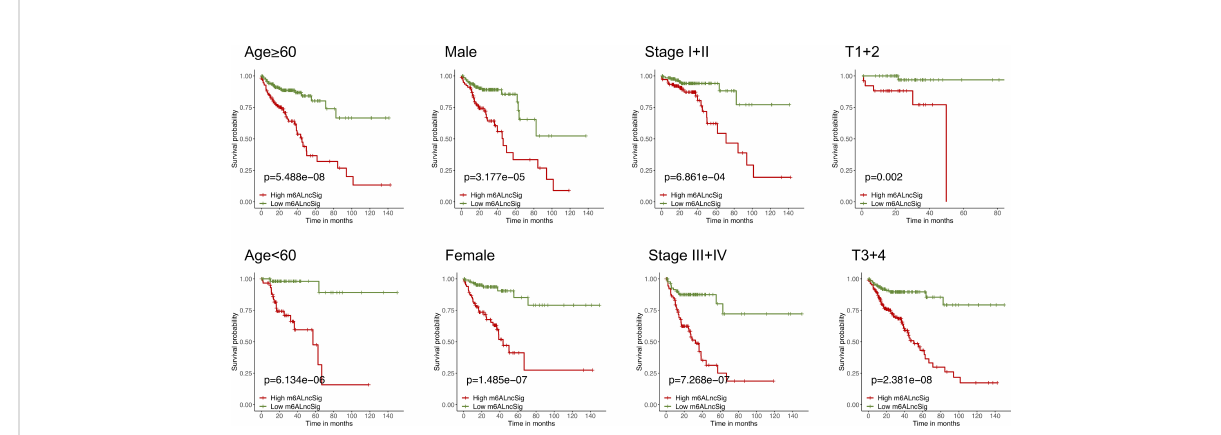
FIGURE 8 KM curves strati fi ed by age, gender, tumor grade, and TNM stage between the high- and low-risk groups in the TCGA entire